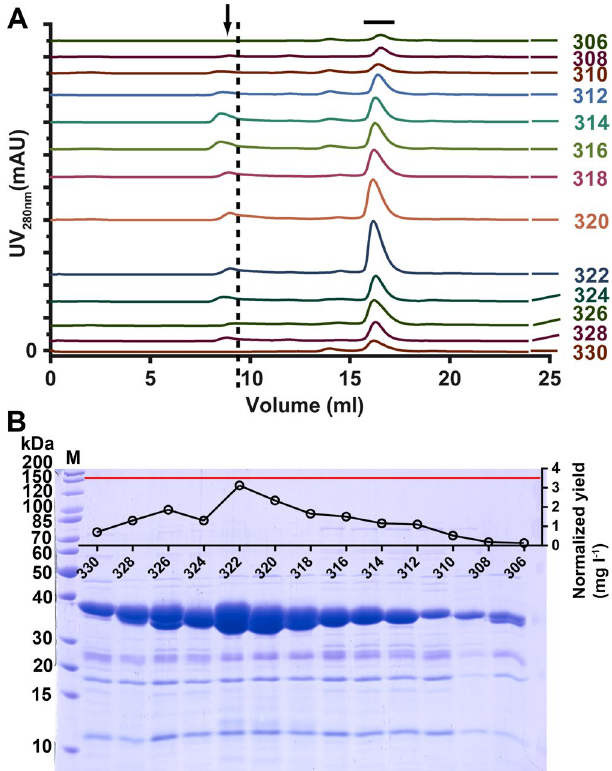
Figure 2. Yields of E. coli expressed ISG65 decrease with construct length. ( A ) Stacked size exclusion chromatograms of all ISG65 constructs expressed in E. coli . Major tick marks correspond to 300 mAU. Numbers indicate the position of the C-terminal truncation. Peaks corresponding to correctly folded ISG65 are indicated by a black horizontal bar, aggregates by an arrow. The void volume of the column is marked by a dashed, vertical line. ( B ) SDS-PAGE analysis of SEC peak fractions. Total protein yields were calculated for each peak by UV 280nm absorption and were normalized to the cell mass in 1 L of culture. All edges of the gel, except the left side, are digitally cropped for clarity. Displayed is the whole separating gel as indicated by the lowest and the highest molecular weight bands of the marker (M).